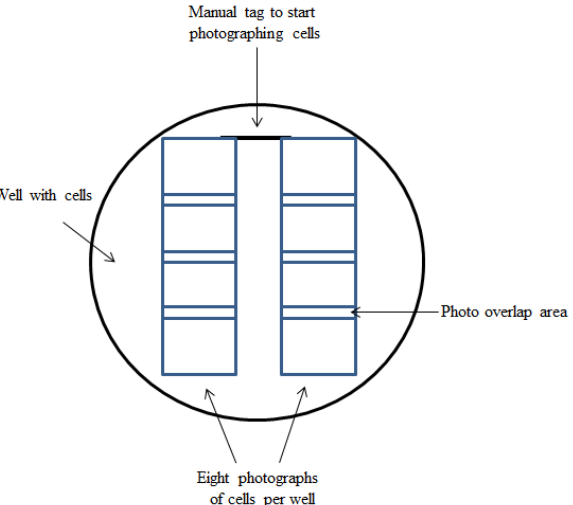
Figure 13. Scheme for obtaining eight photographs at 20× magnification in each well with a culture of mouse embryonic mesencephalic cells and LUHMES cells, first after staining living cells with GBR-BP, and then after fixing and immunostaining the same cells for the subsequent superposition of the respective images.